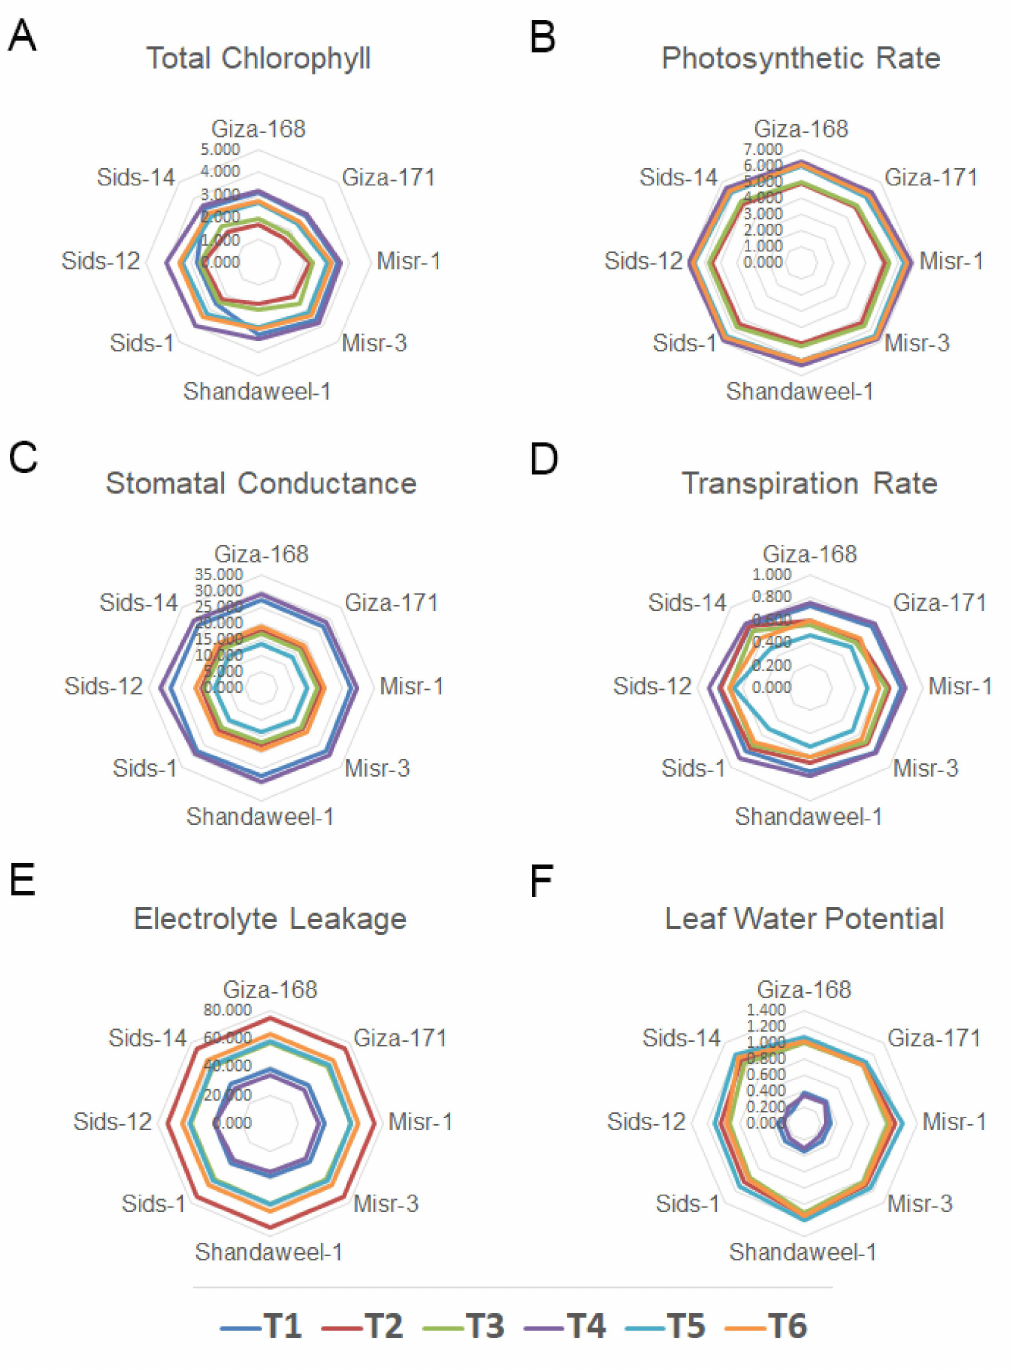
Figure 3. Radar analysis shows eight wheat genotypes’ performances for chlorophyll content, relative water relations, and gas exchange parameters under drought and heat stress and their responses to SeNPs application. ( A ) Total chlorophyll (mg · g − 1 FW), ( B ) photosynthetic rate ( µ mol (CO 2 ) m − 2 s − 1 ), ( C ) stomatal conductance (mmol H 2 O m − 2 · s − 1 ), ( D ) transpiration rate (mmol H 2 O m − 2 · s − 2 ), ( E ) electrolyte leakage (%), and ( F ) leaf water potential (MPa). Treatments: T1, control (regular irrigation, 100% field capacity (FC)) at (day/night) temperatures of 23/17 ± 3 ◦ C; T2, drought stress (60% FC); T3, heat stress (38 ◦ C); T4, 10 mg · L − 1 of SeNPs; T5, drought stress (60% FC) + 10 mg · L − 1 of SeNPs; and T6, heat stress (38 ◦ C) + 10 mg · L − 1 of